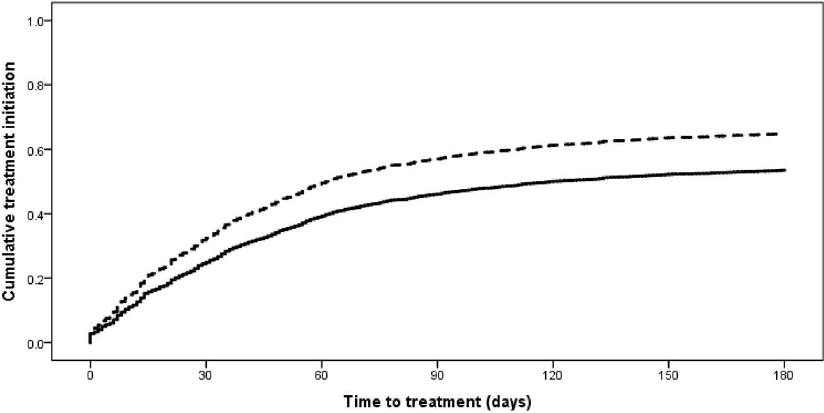
Fig 3. Time to treatment initiation from diagnostic specimen for new rifampicin-resistant tuberculosis patients from the 2011 and 2013 cohorts ( p < 0.001). Solid line: 2011 cohort; dashed line: